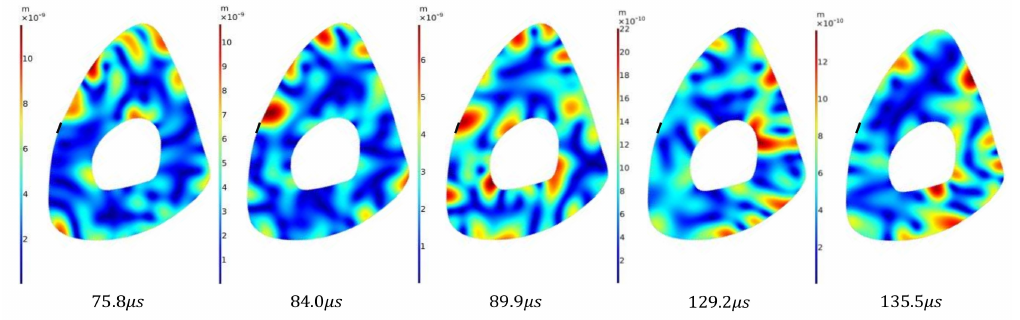
√ v 2 + w 2 , at di ff erent times obtained